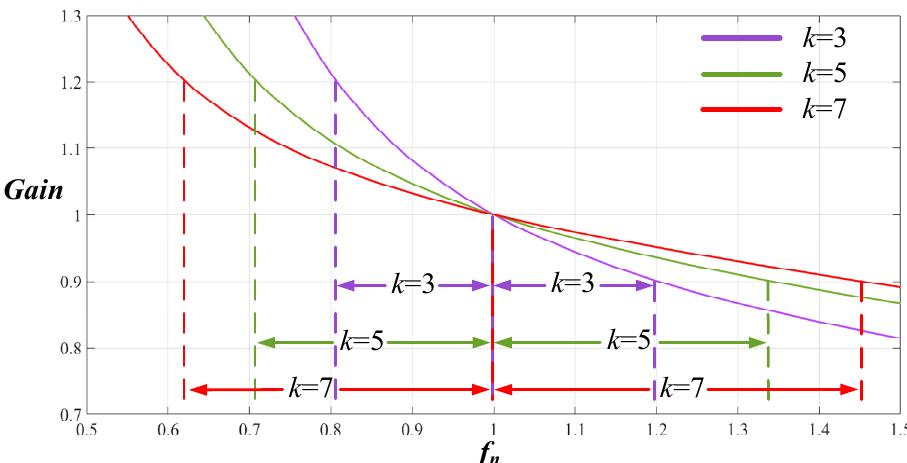
Figure 11. Effects of the k value on the frequency modulation.